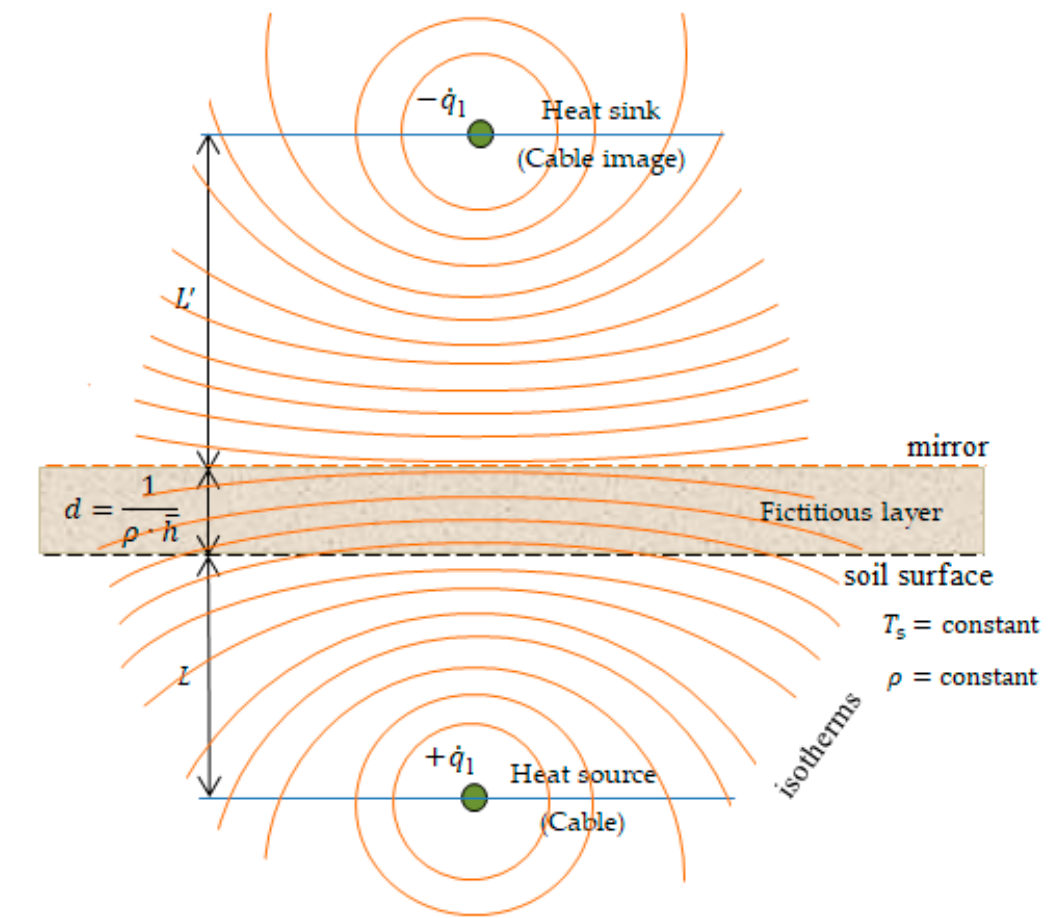
Figure 3. Representation with the equivalent image method for non-isothermal soil surface.